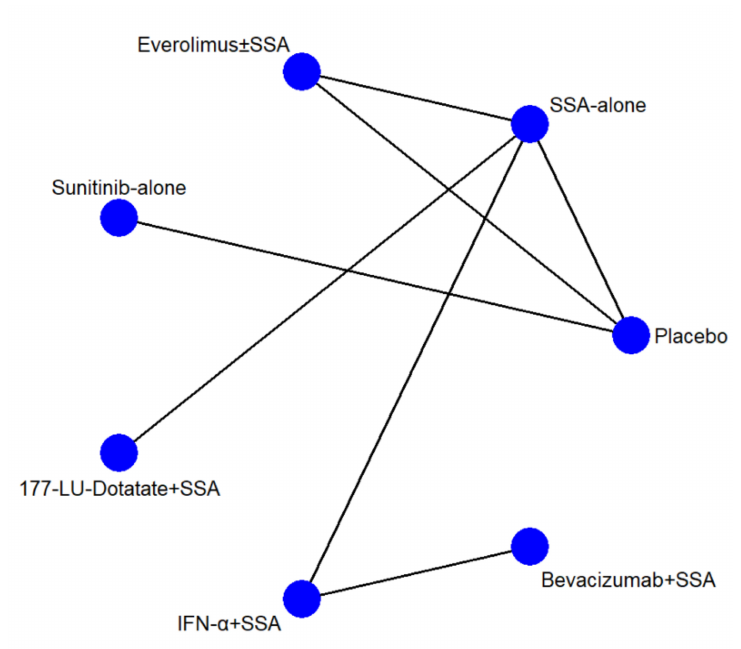
Figure 1. Network geometry. The blue circles represent the treatment arm, while the edges indicate the direct comparison available in the literature. SSA = somatostatin analog; 177 -Lu = Lutezio; IFN- α = interferon alfa.